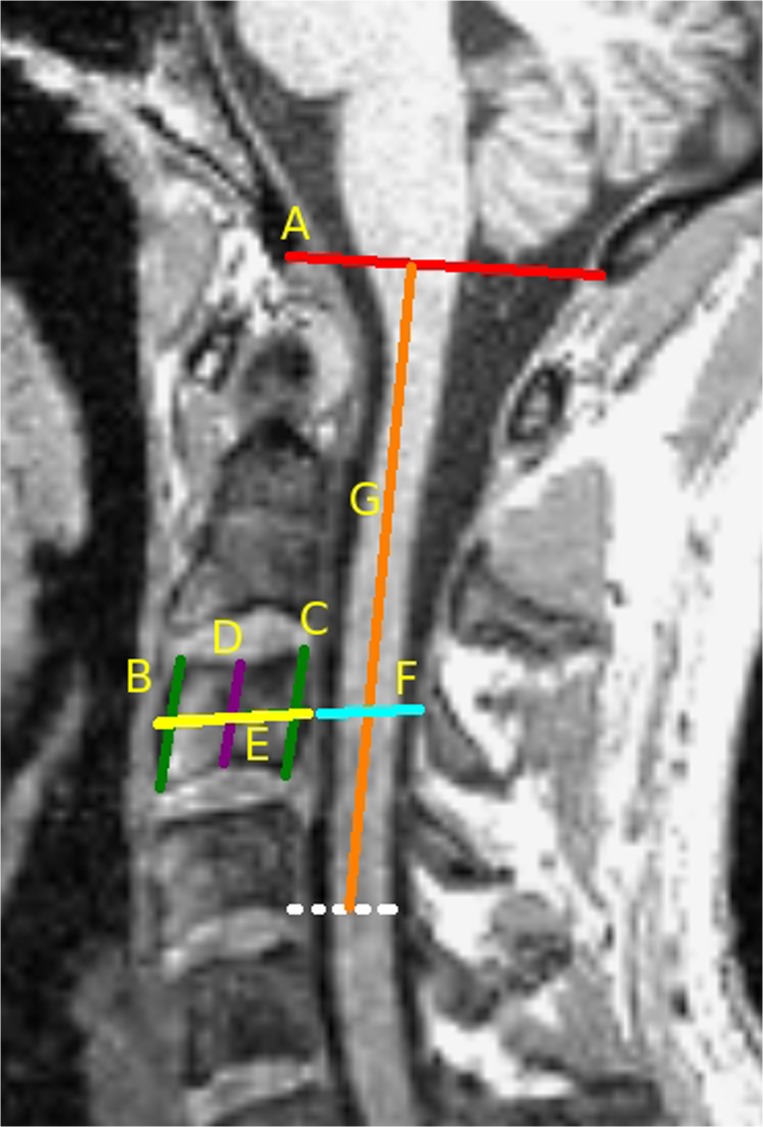
Definition of spinal skeletal based metrics.Cervical skeletal based metrics defined on the sagittal MPRAGE: A: distance between the opisthion and the basion (McRae's line); B: anterior height (AP) of the C3 vertebra; C: posterior height (PH) of the C3 vertebra; D: central height of the C3 vertebra (middle_vertebra_height); E: C3 anterior-posterior vertebral body diameter (ap_vertebra_diameter); F: spinal canal diameter at the C3 vertebra level (ap_canal_diameter); G: Distance between the McRae's line and the bottom of the C4 vertebral body (McRaes_to_C4).